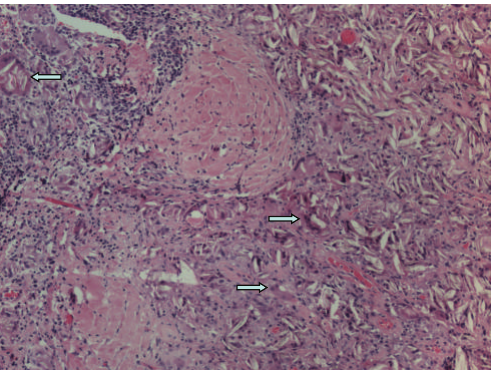
Figure 3: A representative low-power (H&E, × 200) photograph showing crystals surrounded by multinucleated foreign-body giant cells